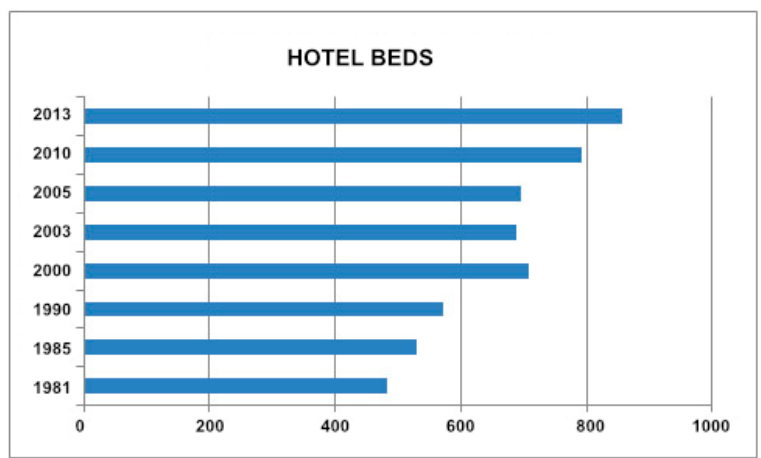
Figure 9. Evolution of the number of hotel beds available at La Garrotxa from the creation of the natural park in 1982 to date [23].